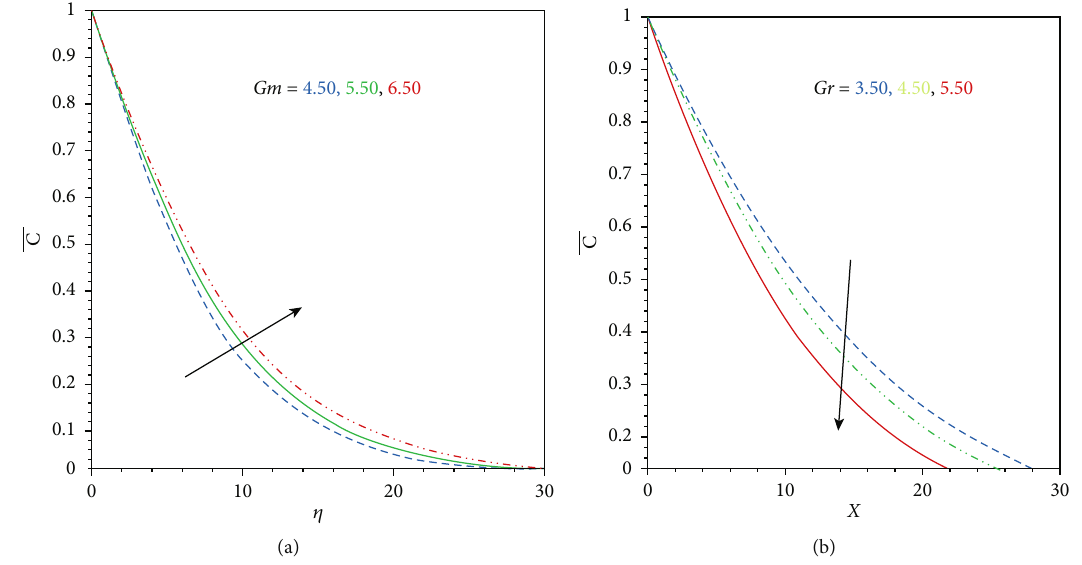
Figure 5: Justi fi cations of the parameter (radiation) on concentration pro fi les for Grashof number (a) in the presence of radiation and (b) in the absence of radiation. Table 2: Justi fi cations of the parameter (radiation) for Figures 5(a) and 5(b) at Y = 1 . Concentration Absence of radiation